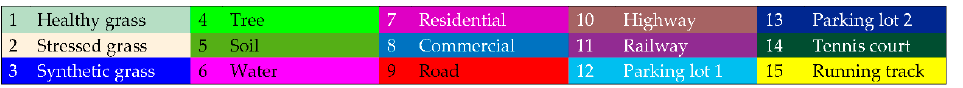
Figure A1. ASD classification maps.